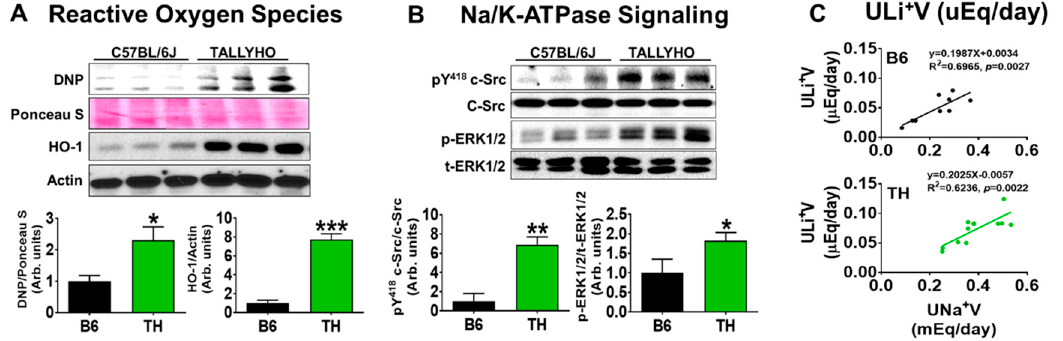
Figure 2. Na/K-ATPase signaling is implicated in proximal tubule Na + handling and blood pressure regulation. At the age of 23-27 weeks, TH mice were compared with wild-type (WT) B6 mice. Western blots and quantification of kidney cortex tissues showed that activated baseline protein carbonylation (DNP) and heme oxygenase (HO-1) ( A ) and Na/K-ATPase signaling (c-Src and ERK1/2 phosphorylation) ( B ) were observed in obese TH mice. ( C ) Correlation of lithium excretion (ULi + V) and Na + excretion rate (UNa + V) in TH and B6 mice. The correlation analysis was evaluated by Pearson correlation test. Regression line was drawn. B6: n = 10, r = 0.8346, p = 0.0027; TH: n = 12, r = 0.7897, p = 0.0022. p values for the regression coefficient are given. Results in (A) and (B), n = 4. * p < 0.05; ** p < 0.01; *** p < 0.001 versus B6. Table 1. Systolic blood pressure, total and fractional excretion of Na + in C57BL/6J and TALLYHO/JngJ mice on normal chow.